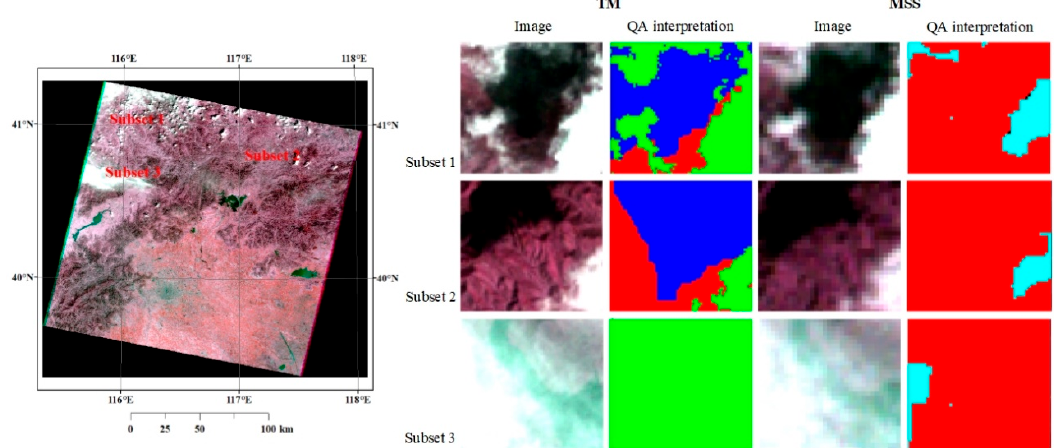
Figure 9. Interpretation for three subsets extracted from the Landsat 5 MSS and TM Quality Assessment (QA) band information: color image (R: NIR channel, G: Green channel, B: Red channel) and the interpreted information. Specifically, the QA interpretations for TM are cloud (green), cloud shadow (blue), and “clear terrain” (red), while for MSS are cloud (cyan) and clear terrain (red). Generally, QA information for TM imagery is more reliable. All subsets illustrated are for the MSS and TM pairs of Case 3 (Table 3).